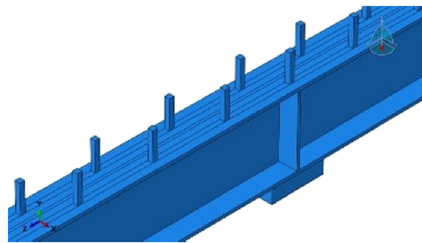
Figure 4: Shear connectors distribution for Group B.